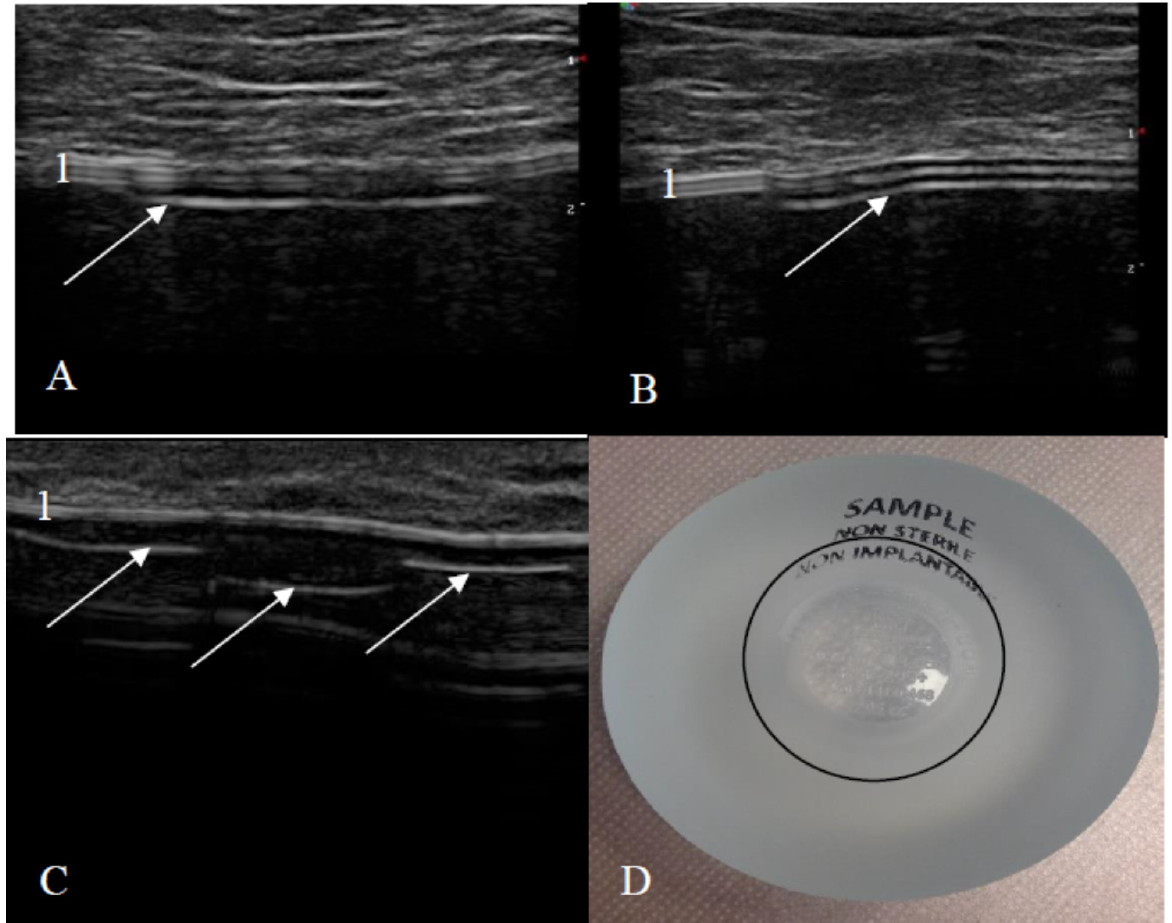
Figure 5. Breast implant displacement: signs of the flipped implant on ultrasound. ( A , B ) Images of the bottom of the same implant (manufacturer Motiva): ( A ) beginning of the implant bottom and ( B ) middle of the implant bottom; ( C ) only the bottom of the other implant (1—an intact shell, white arrows—the implant bottom looks like an abnormal shell: one additional line is seen only in the area of the implant bottom); and ( D ) natural image of the implant (a black circle indicates the implant bottom). Table 1. Time since primary breast implant